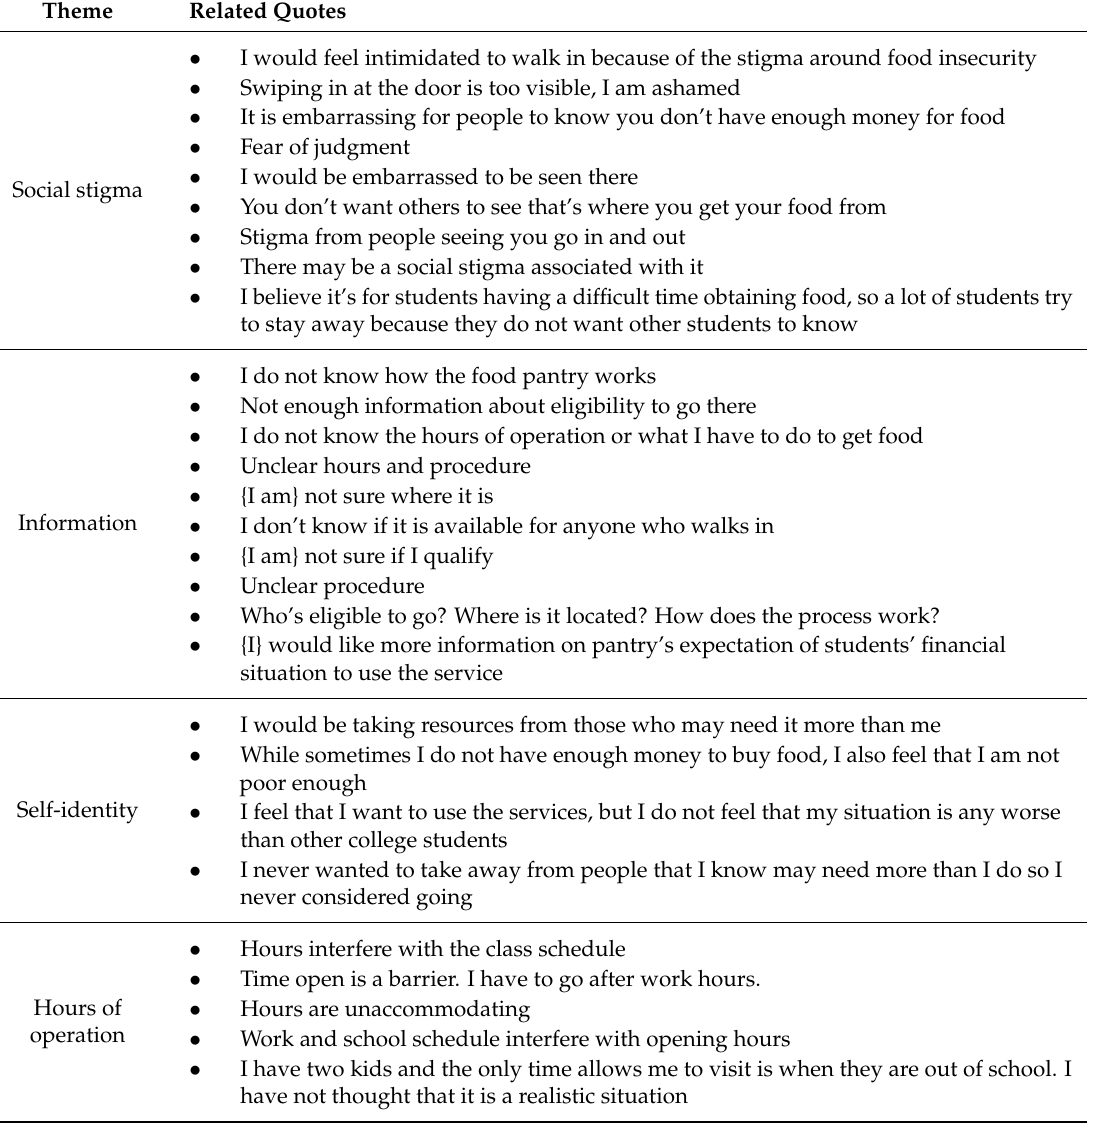
Table 4. Thematic analysis of qualitative data on barriers to using the campus pantry by college students in the United States,